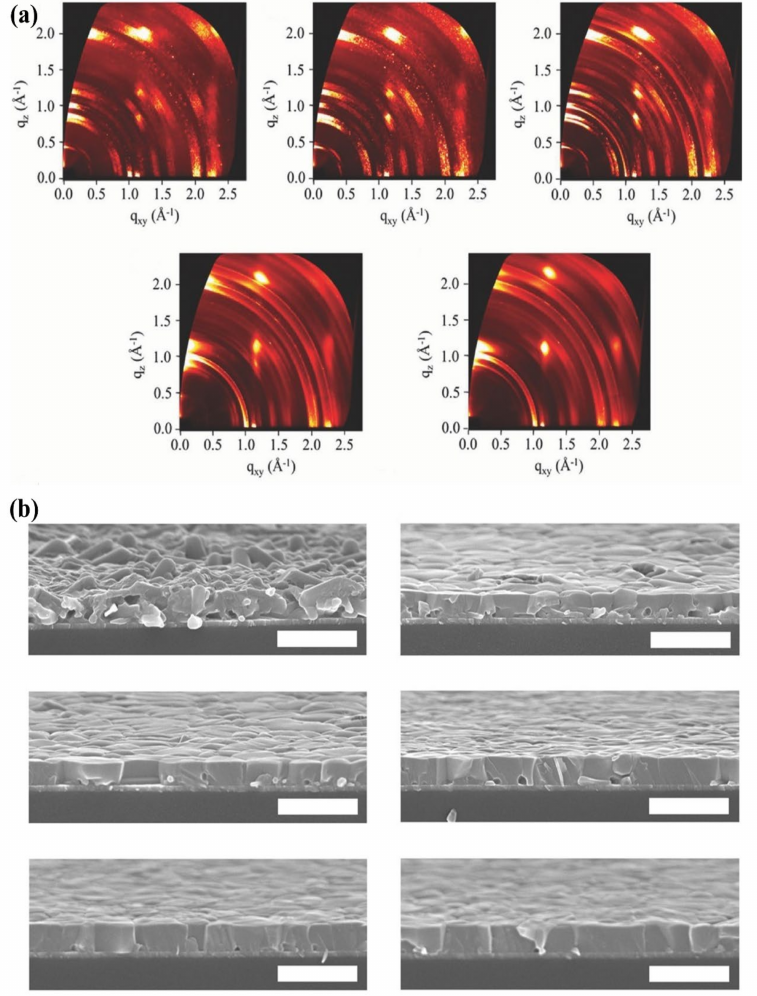
Figure 1. ( a ) 2D GIWAXS patterns recorded during annealing at 80 ◦ C; images were captured at t = 0, t = 8 min, t = 45 min, t = 117 min, and t = 164 min (from left to right). (Reprinted with permission from Ref. [28]. Copyright 2016 Wiley-VCH GmbH). ( b ) SEM characterization of MAPbI 3 films annealed for different times (from left to right): 0 s, 1 s, 3 s, 30 s, 60 s, and 10 min. Scale bars, 1 µ m. Reprinted with permission from Ref. [25]. Copyright 2021 American Association for the Advancement of